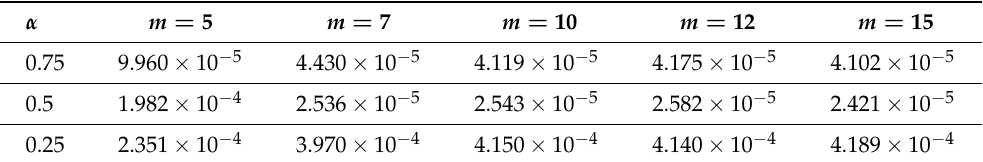
Table 2. The modified AAA algorithm: errors of the solution of the discrete scheme (21) and (22) for α = 0.75,0.5,0.25 and a sequence of parameters m .